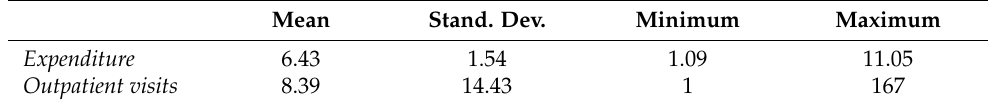
Table 1. Summary of descriptive statistics of the two response variables considered.